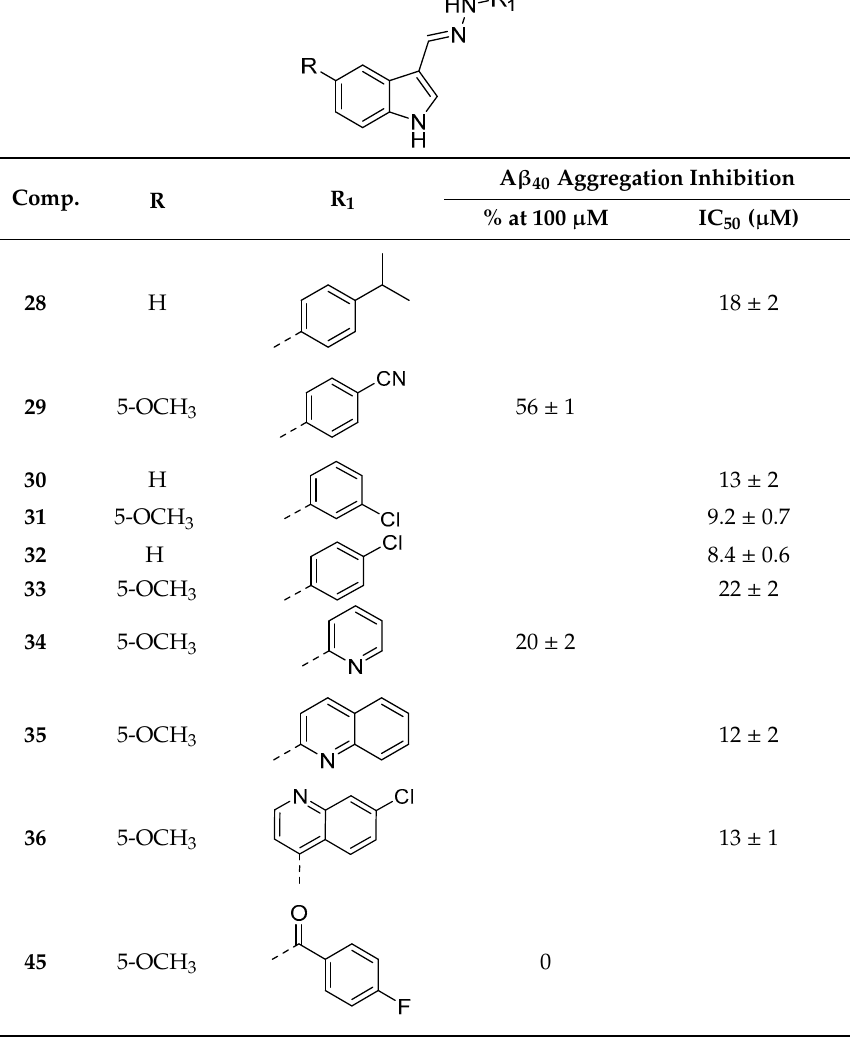
Table 3. Inhibition data of new indole-3-carbaldehyde hydrazones 28 – 36 and 45 . Comp.